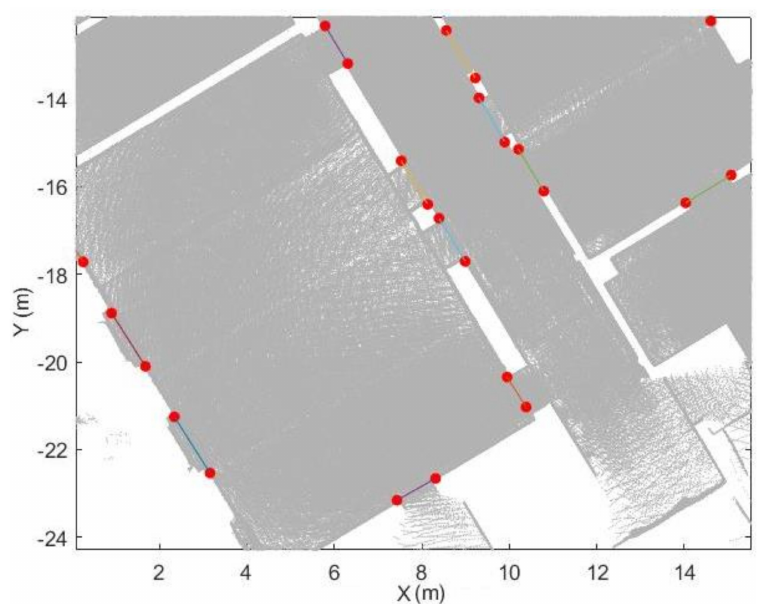
Figure 12. Example result of Step 3 (the final extracted openings are shown in red segments).